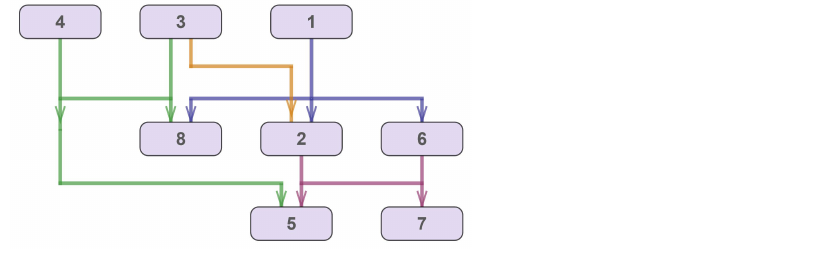
Figure 10. An example of the optimal layout of the hypergraph with the same ordinates of horizon- tal